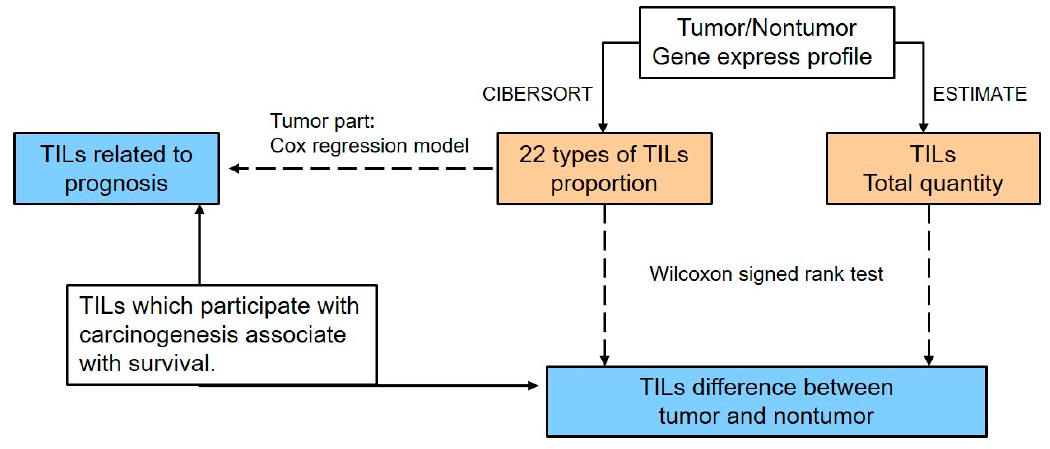
Figure 1. An overview of this study.